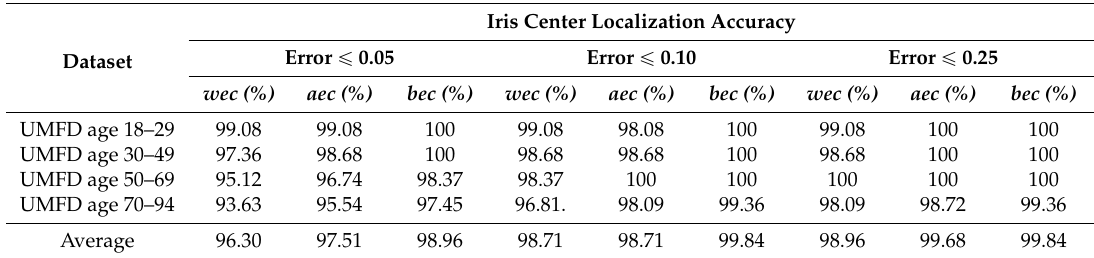
Table 2. Iris center localization results on the University of Michigan face database.